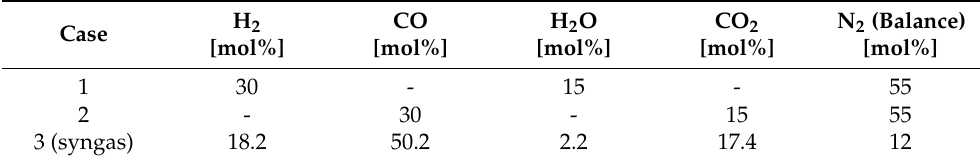
Table 1. Inlet mole fractions during the three cases simulated with iron-based OC [11].